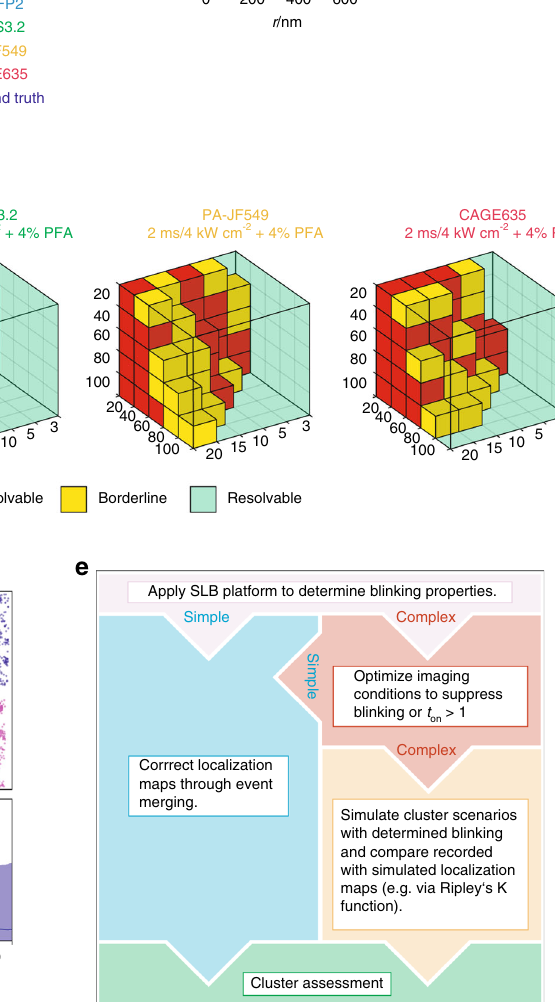
Cluster assessment